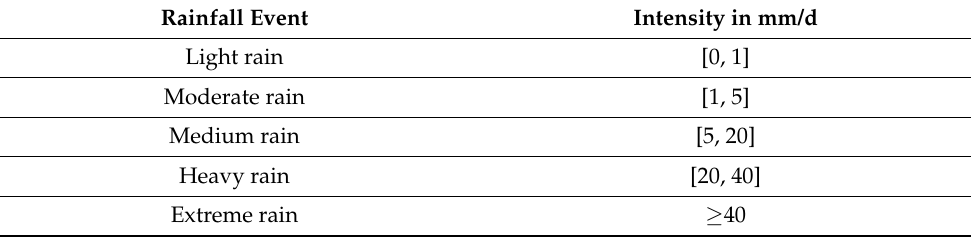
Table 5. Classification of rainfall events according to their daily intensity. [a, b]: the interval includes the values strictly between a and b. [a, b]: The interval includes values greater than, or equal to a and strictly less than